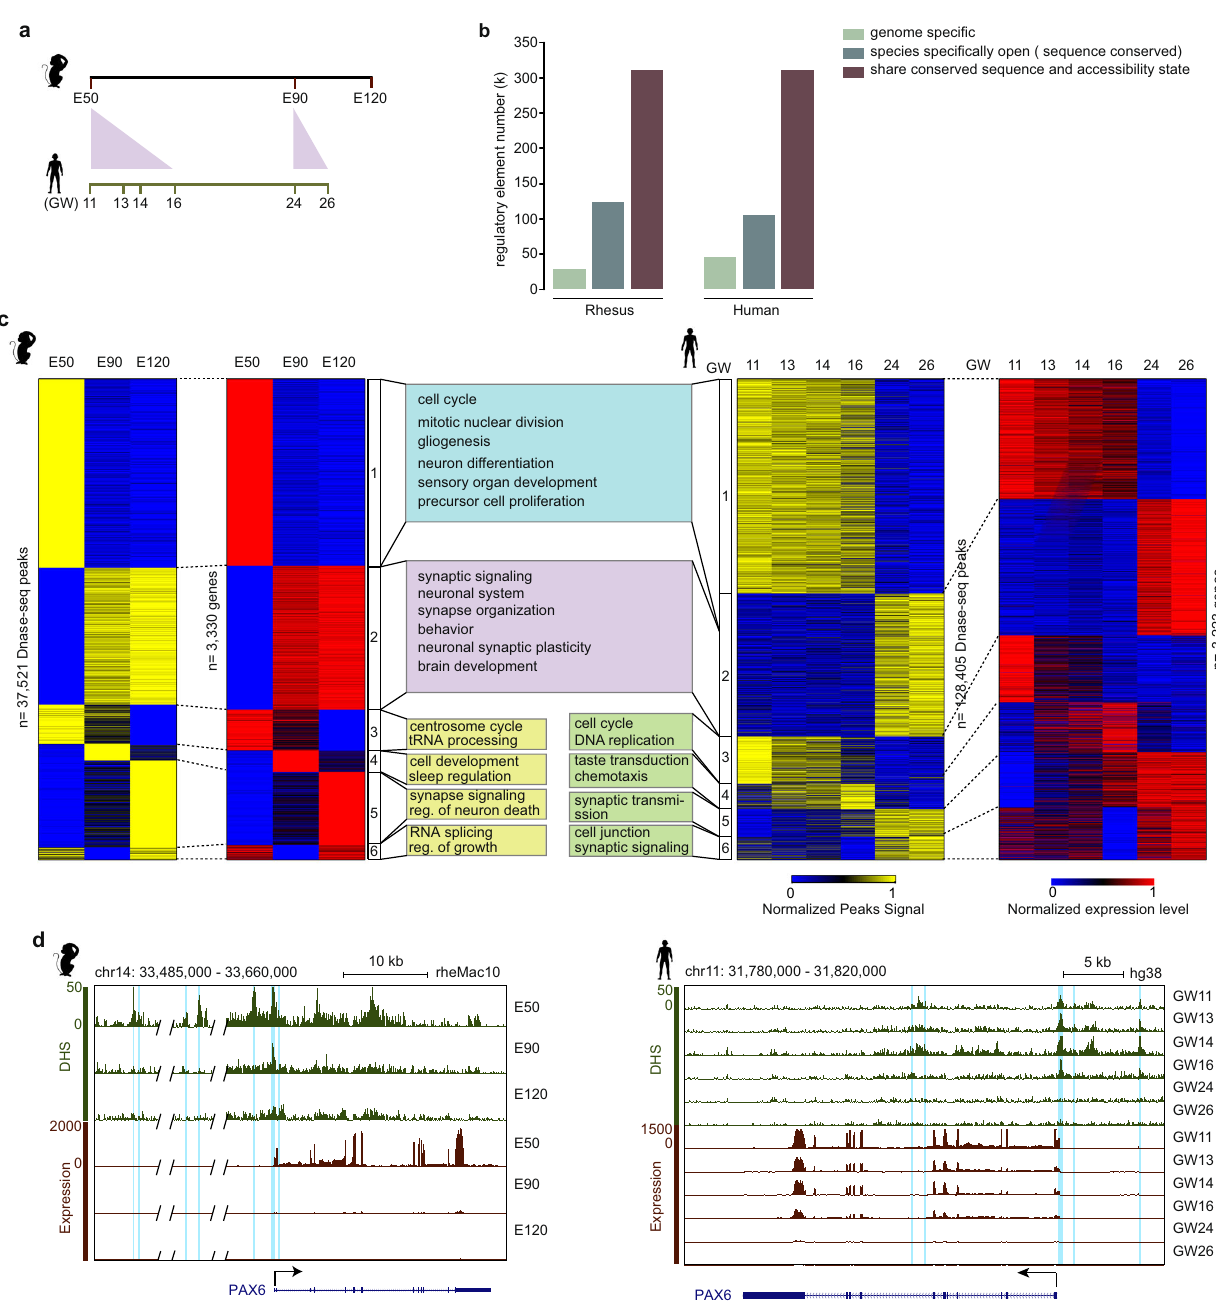
Fig. 1 Dynamics of the chromatin accessibility landscape during human and rhesus PFC development. a Schematic of developmental stages examined in rhesus monkeys and humans. b The number of conserved and divergent regulatory elements between rhesus and human PFCs. c The dynamics of gene expression and the DHS signal of paired regulatory elements in rhesus (left) and human (right) PFC. The potential regulatory element-gene pairs are classi fi ed into 6 clusters by the K-means method. The middle panel shows the signi fi cantly enriched GO terms. Reg. represents regulation. In cluster 6, all the DHSs assigned to the orthologous genes, in addition to the DHSs detected separating the gene activation at different stages, are shown. d Genome browser view of the expression of PAX6 and the DHS signal of the paired regulatory elements during PFC development in rhesus monkeys (left) and humans (right). The light blue shadows mark the paired regulatory